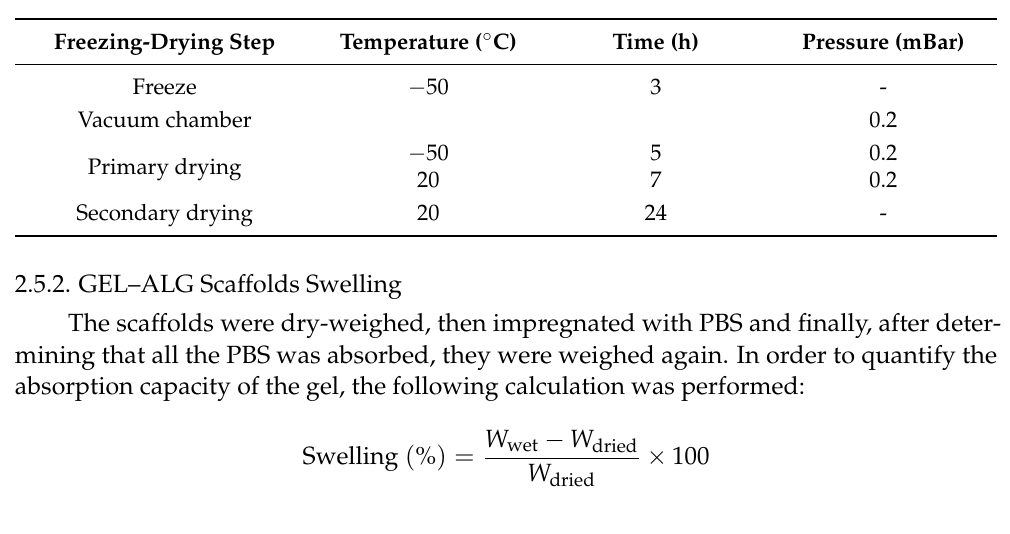
Table 1. Lyophilization